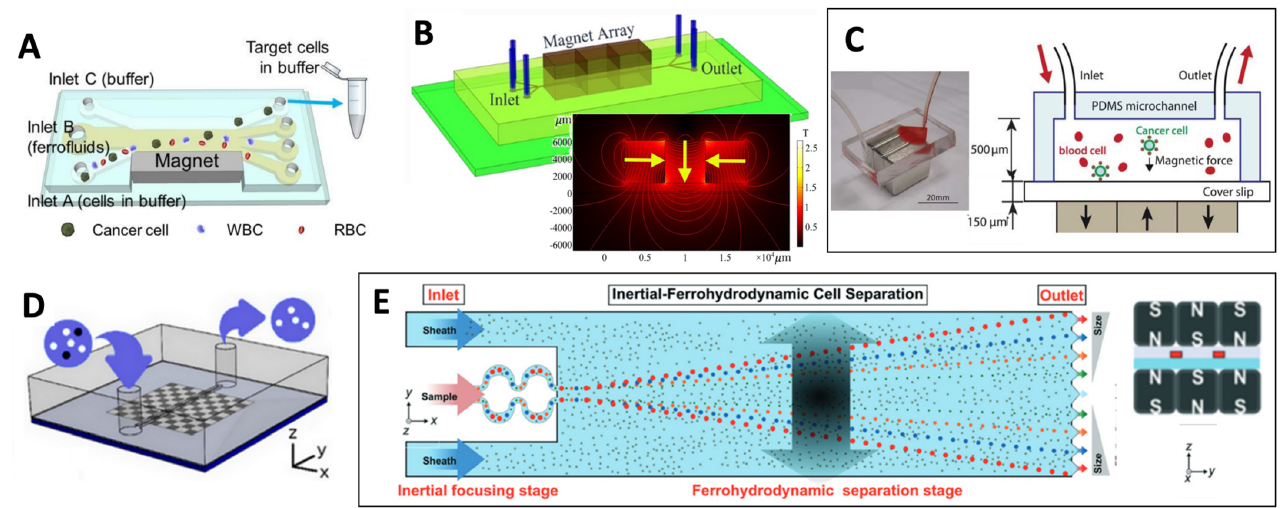
Figure 11. Macroscale permanent magnets in microfluidic separation devices. ( A ) Illustration of a simple magnet separation device exerting a negative magnetophoretic force on CTCs and WBCs and a positive force on RBCs in a ferrofluid. Reprinted from [77], with the permission of Royal Society of Chemistry; permission conveyed through Copyright Clearance Center, Inc. ( B ) Illustration of Halbach configuration; distribution of the magnetic field from one side to farther distances. Reprinted with permission from [71]. Copyright 2020 American Chemical Society. ( C ) Picture (scale bare is 20 mm) and schematic illustration of a microfluidic device with three magnets with opposite polarities placed under the channel for CTCs isolation. Reprinted from [166], with the permission of Royal Society of Chemistry; permission conveyed through Copyright Clearance Center, Inc. ( D ) Illustration of an array of micromagnets obtained by thermomagnetic patterning of NdFeB hard magnetic film. Reprinted from [167], with the permission of AIP Publishing. ( E ) Schematic of inertial-ferrohydrodynamic cell separation. Six magnets, placed above and below the channel, create a maximum flux density at the center of the channel. Reprinted from [170] with the permission of Royal Society of Chemistry; permission conveyed through Copyright Clearance Center, Inc.